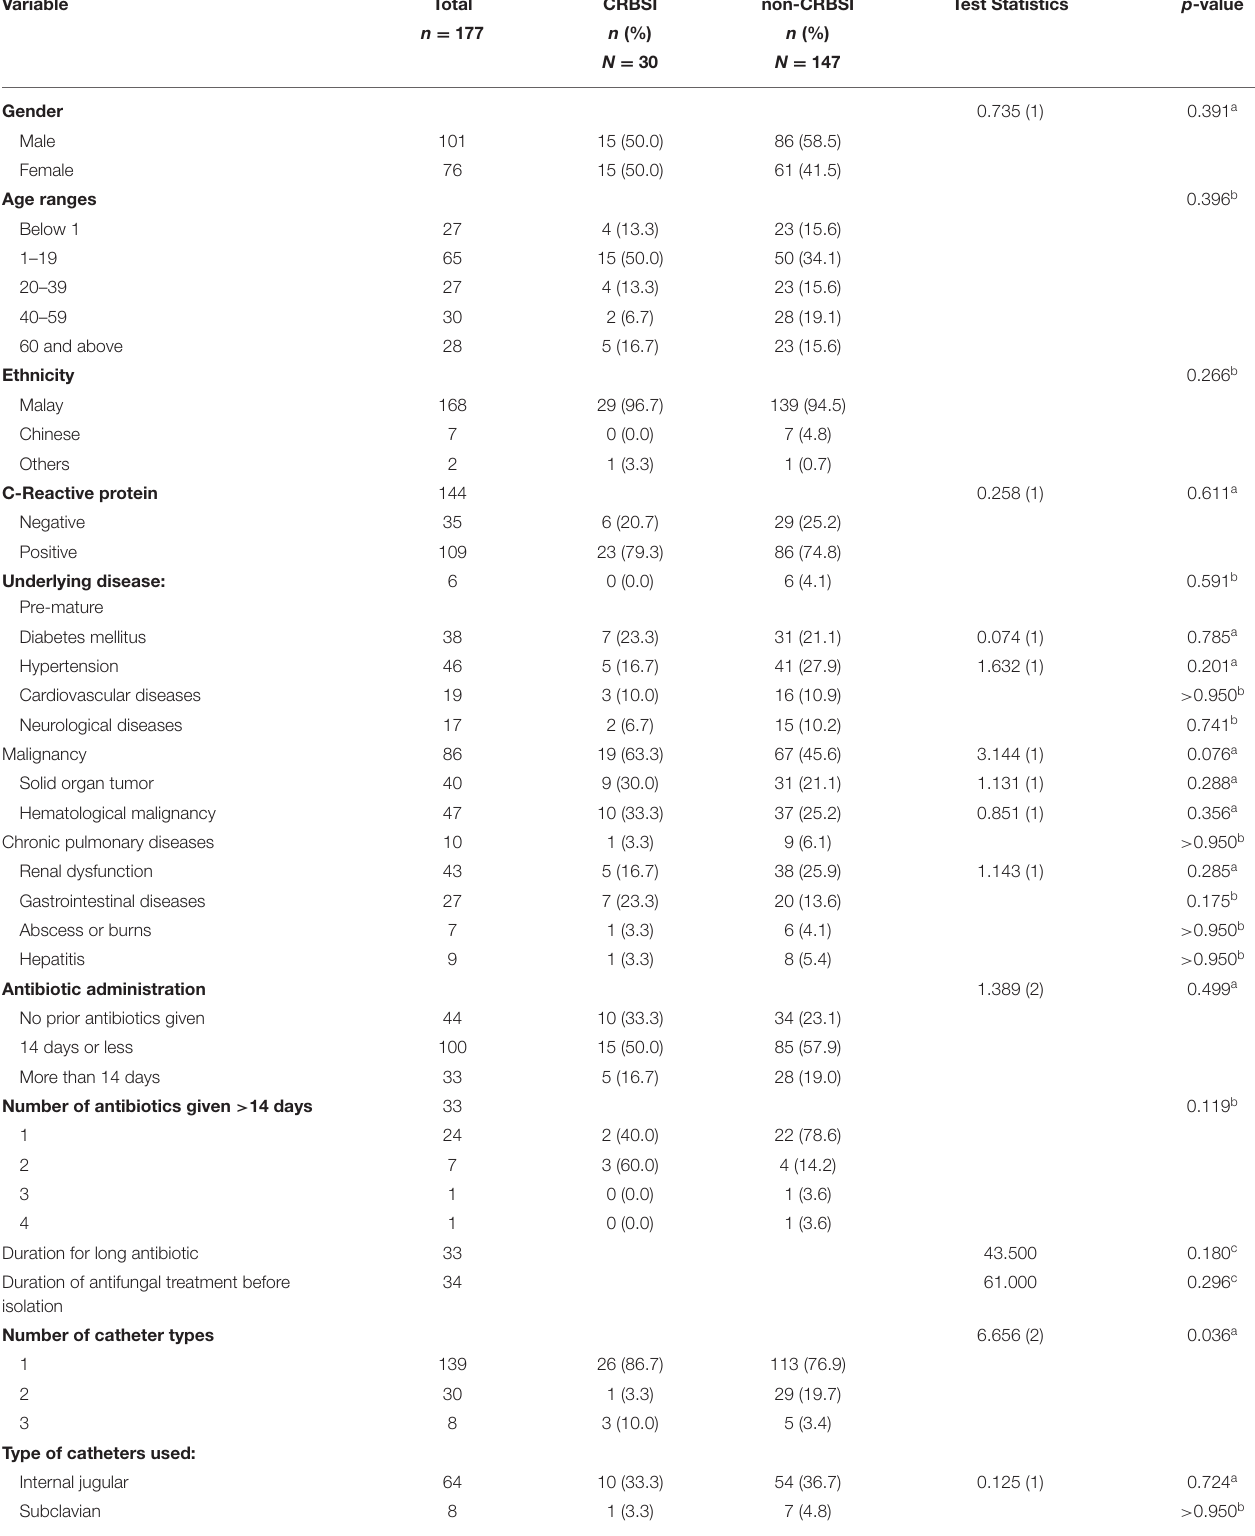
TABLE 2 | Comparison between patients with catheter-related bloodstream infection (CRBSI) and those with non-CRBSI caused by C. parapsilosis .